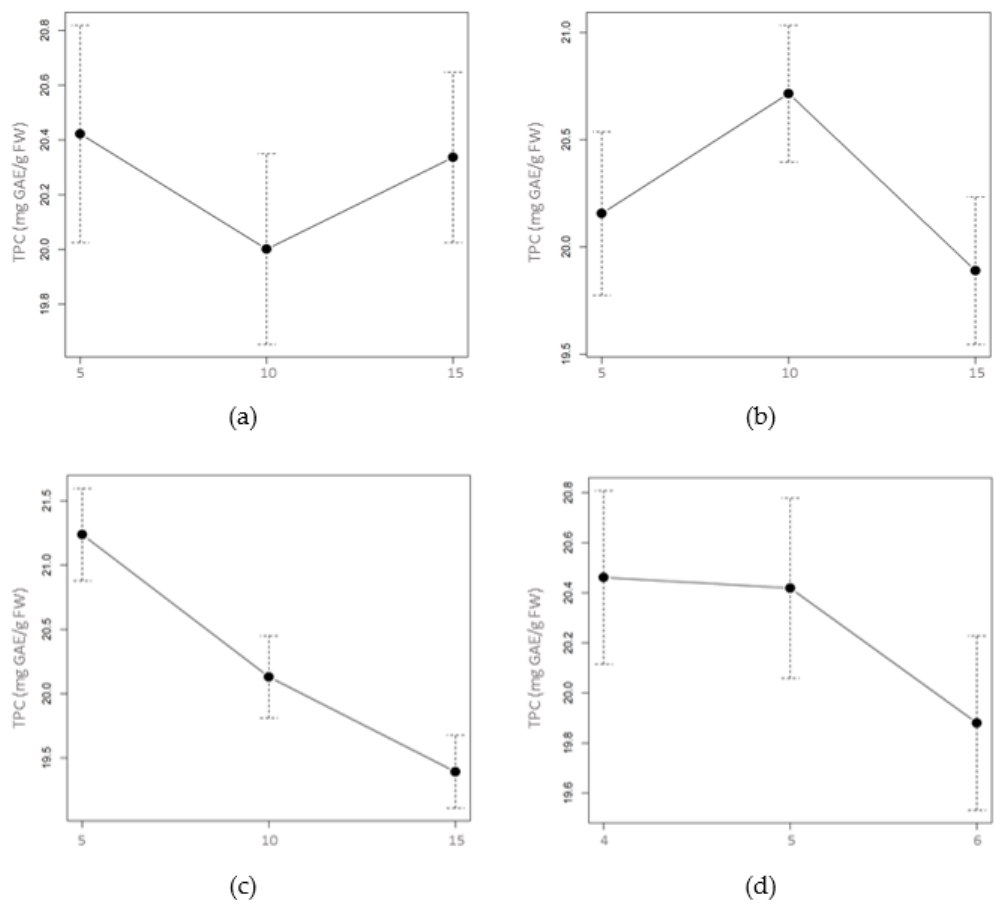
Figure A1. The total phenolic content (TPC; mg GAE/g FW) in the ethanolic extracts plotted as a function of the individual enzyme concentration (5 – 15 IU), ( a ) cellulase, ( b ) pectinase, ( c ) laccase, and ( d ) pH (4 – 6).